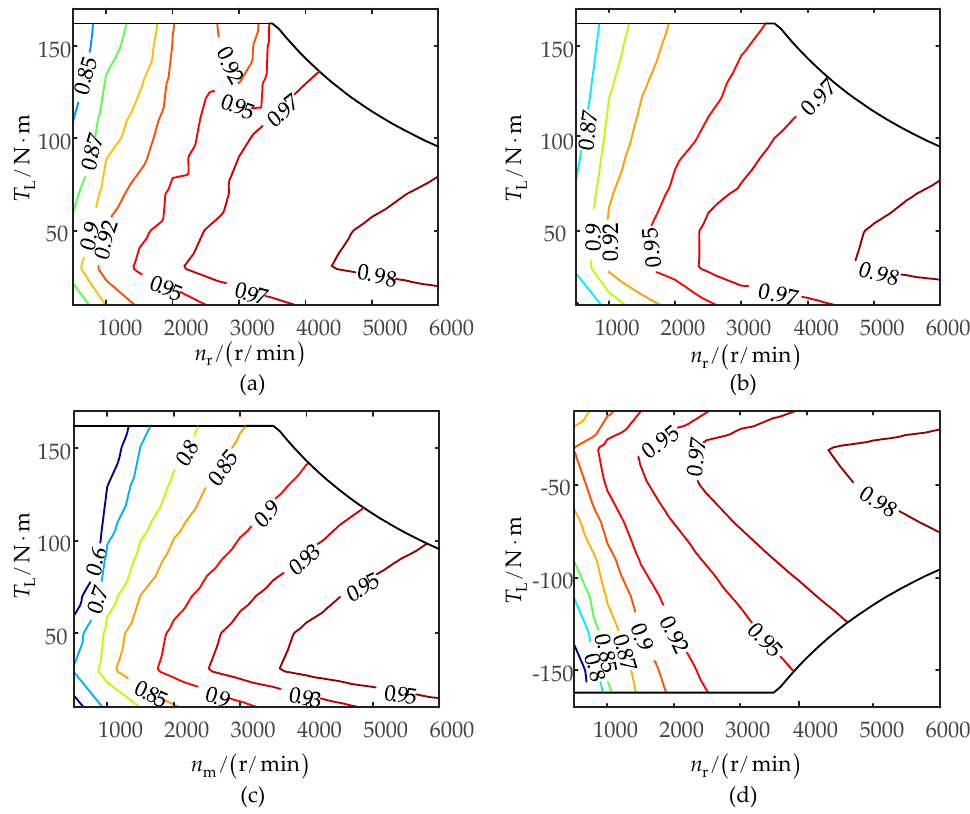
Figure 11. Efficiency maps of CRPM-DFM: ( a ) in hybrid driving mode; ( b ) in pure electric driving mode; ( c ) in parking charging mode; ( d ) in regenerative braking mode.